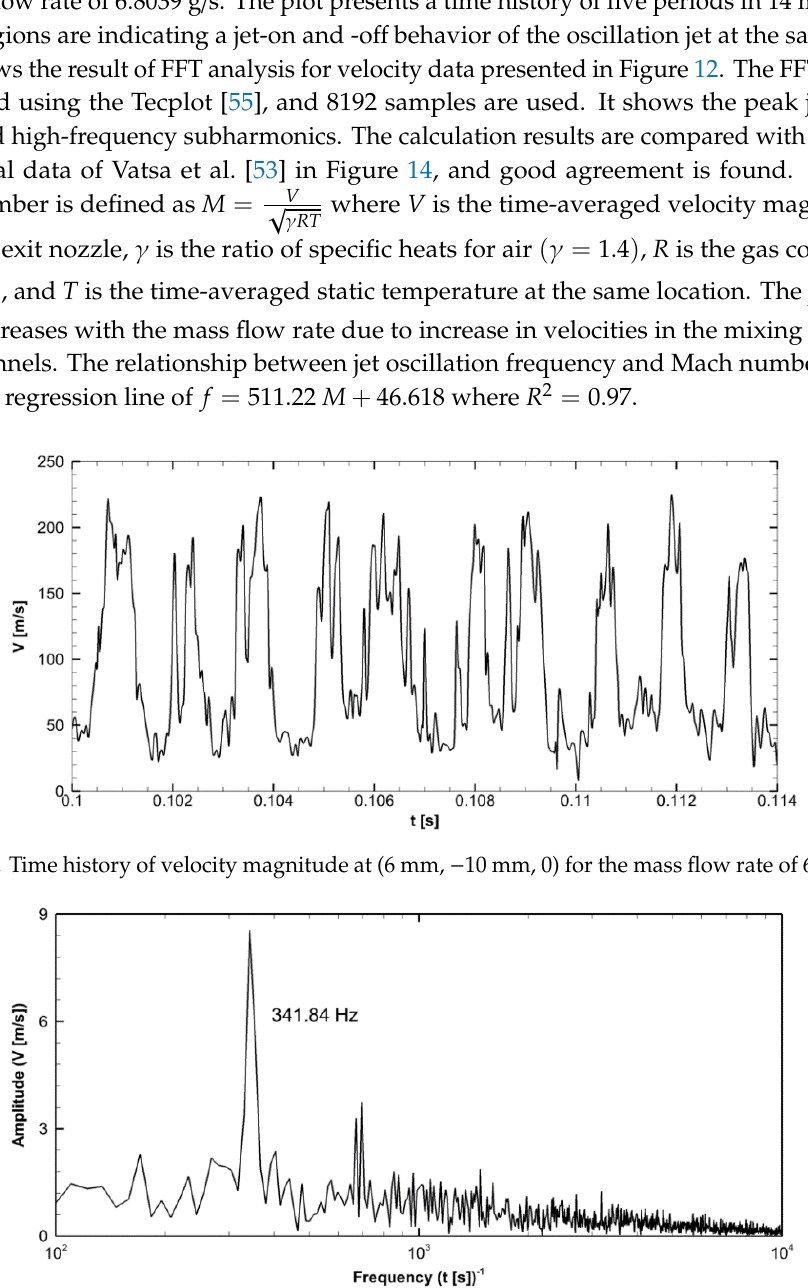
Figure 13. FFT analysis results of the time history of velocity magnitude recorded at (6 mm, − 10 mm, 0) for the mass flow rate of 6.8039 g/s. Reproduced with permission from [9].